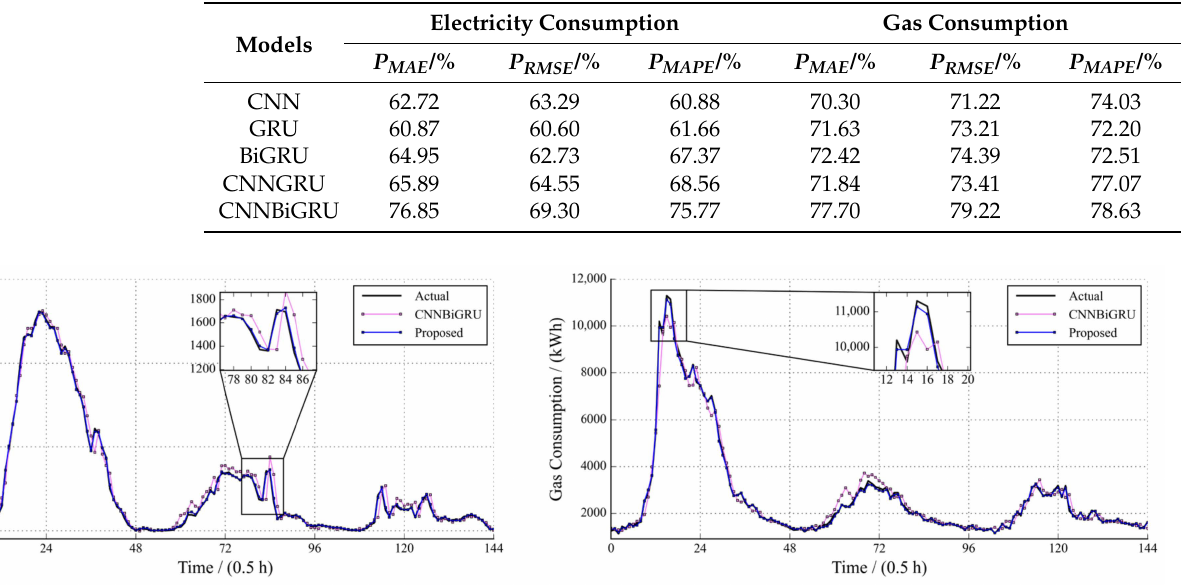
Figure 8. Comparison of one-step ahead prediction results for the SSA-CNNBiGRU and CNNBi- GRU